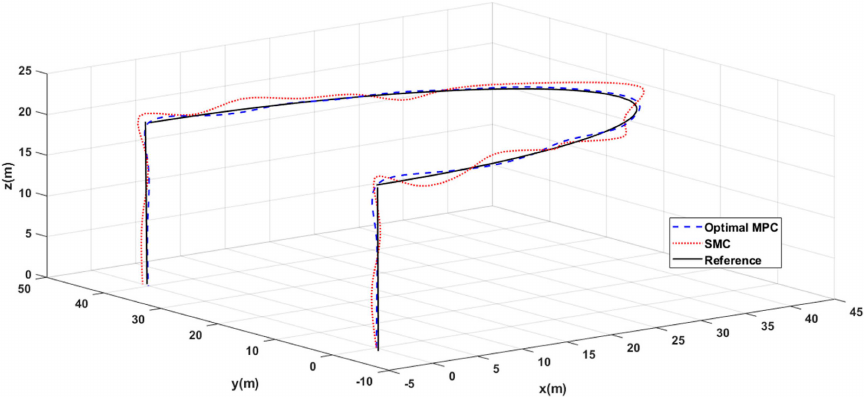
Figure 6. The result of applying the proposed control method and SMC method [50] to the helicopter in the fourth scenario with 15 m/s wind force.